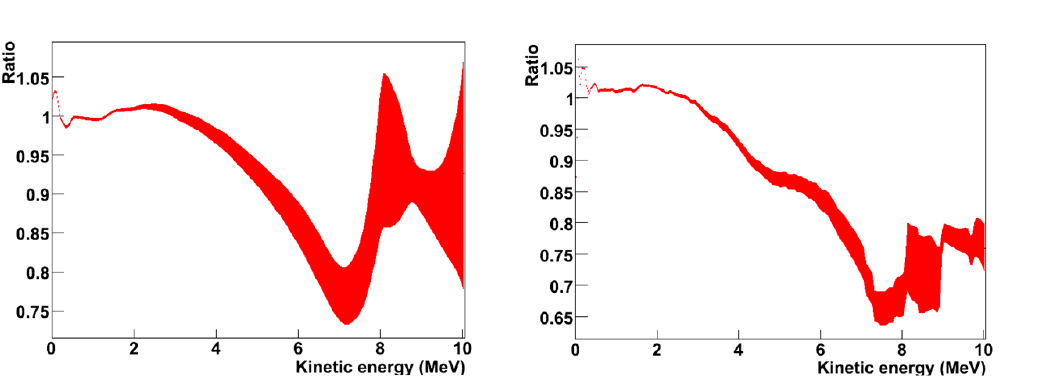
Figure 6. Normalized ratio of the calculated electron (left) and anti-neutrino (right) energy spectra when transi- tions are treated according to their type to the spectra when transitions are treated as allowed. Only uncertainties on spin-parity assignement in ENSDF have been